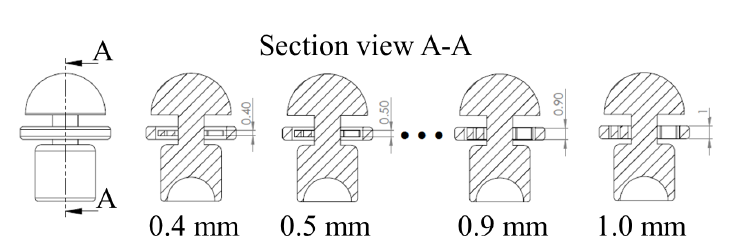
Figure 5. Design of the dome-shaped element exploring different spring leg thicknesses.